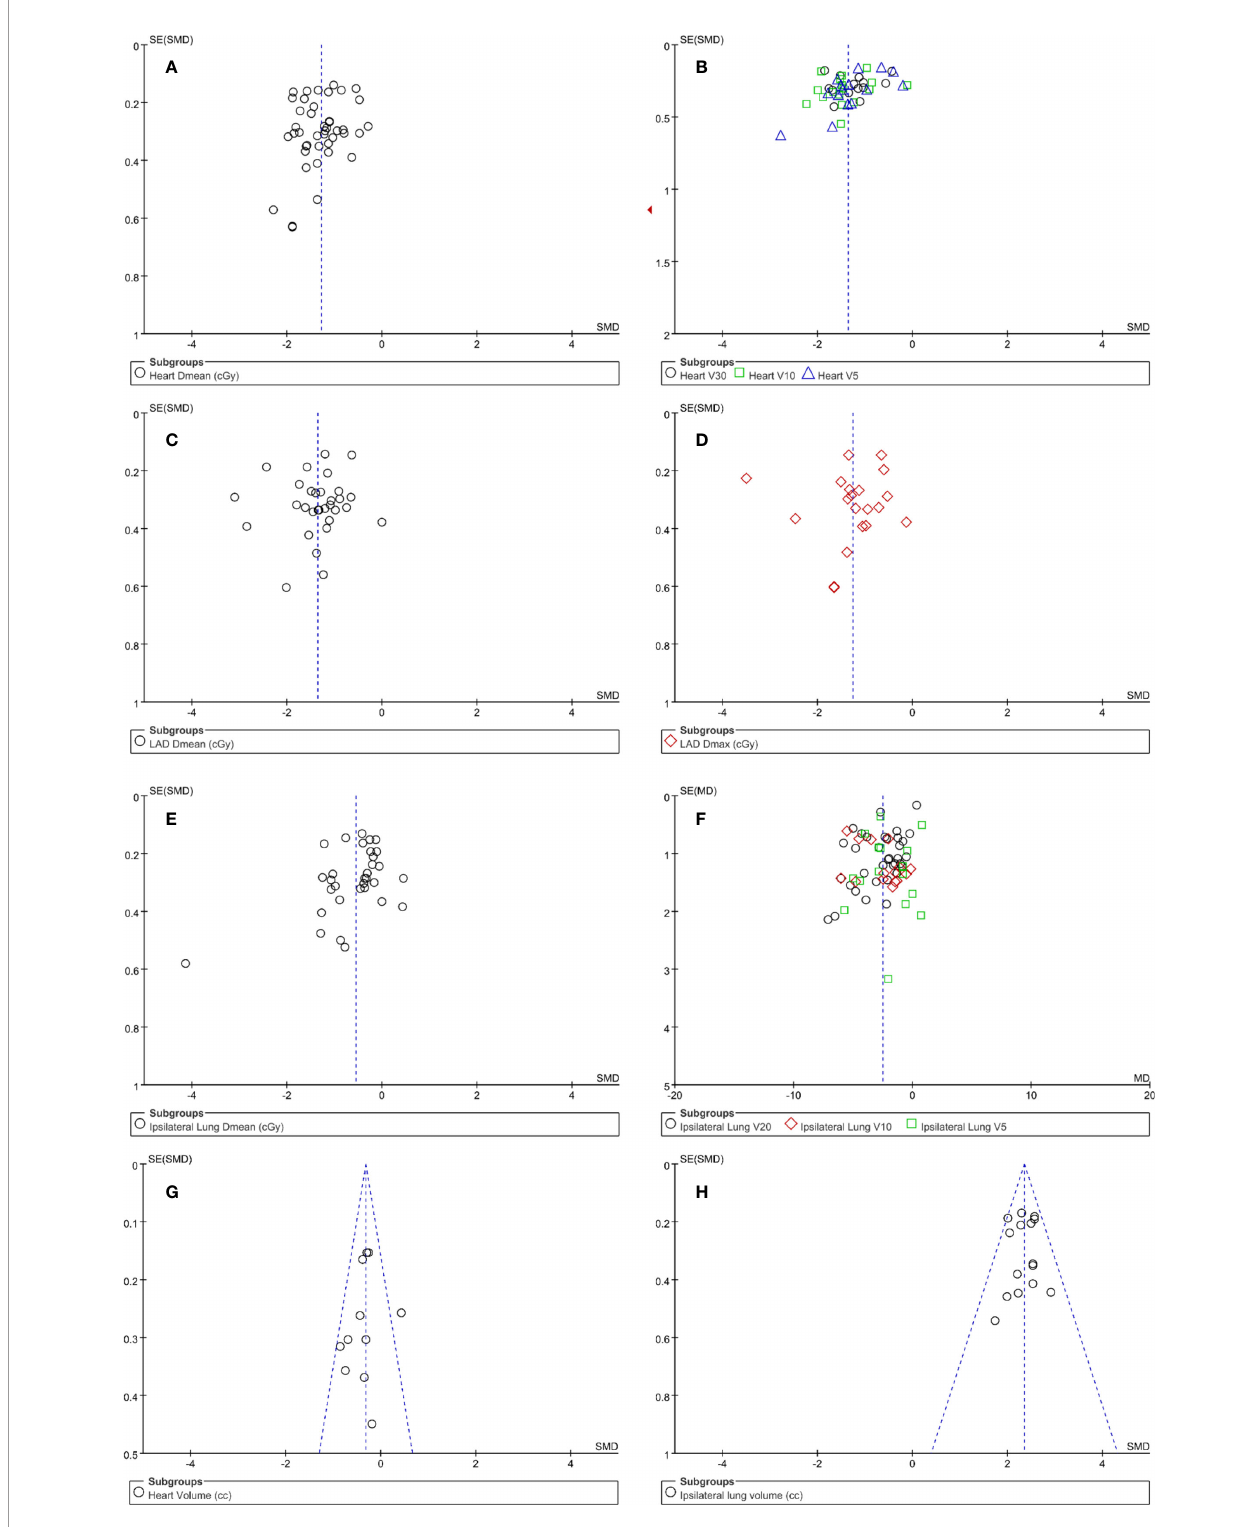
FIGURE 10 | Funnel plots for potential publication bias. Funnel plot analysis of heart dose (A, B) , LAD dose (C, D) , ipsilateral lung dose (E, F) , heart volume (G) and ipsilateral lung volume (H)